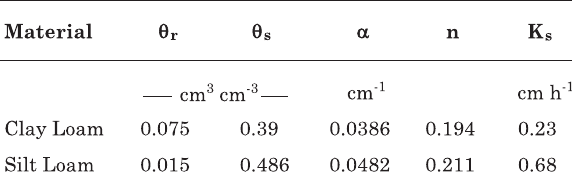
Table 1. Hydraulic properties for the soil materials used in the